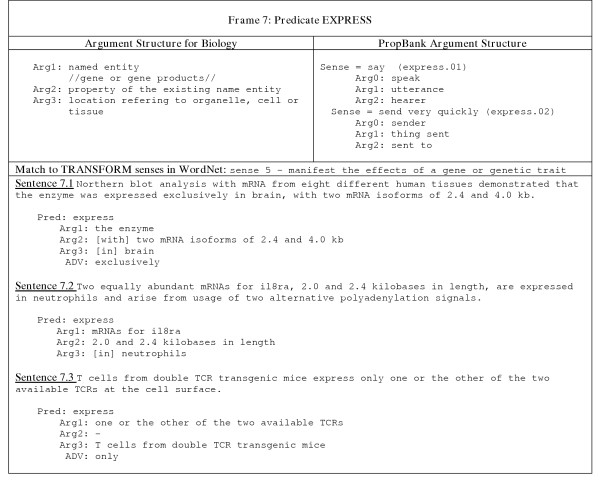
Predicate-argument structure of express (a group D predicate) Predicate express is used in biological documents to mean as WordNet [43] sense 5 – manifest the effects of a gene or genetic trait which is totally different from the usage found in business news (i.e. say and send very quickly). Thus express is classified to group D – different sense or does not occur.